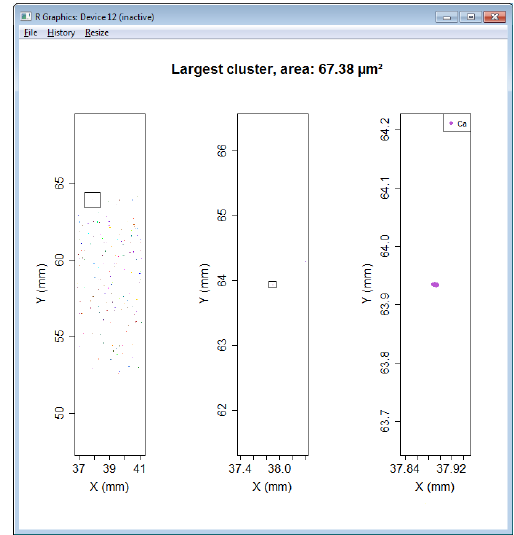
Figure 8: Histogram showing the cluster length distribution in the specimen.